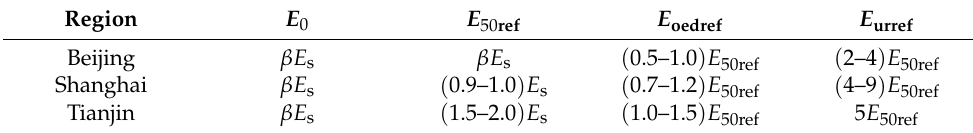
Table 3. Modified Mohr-Coulomb model parameter empirical value table.